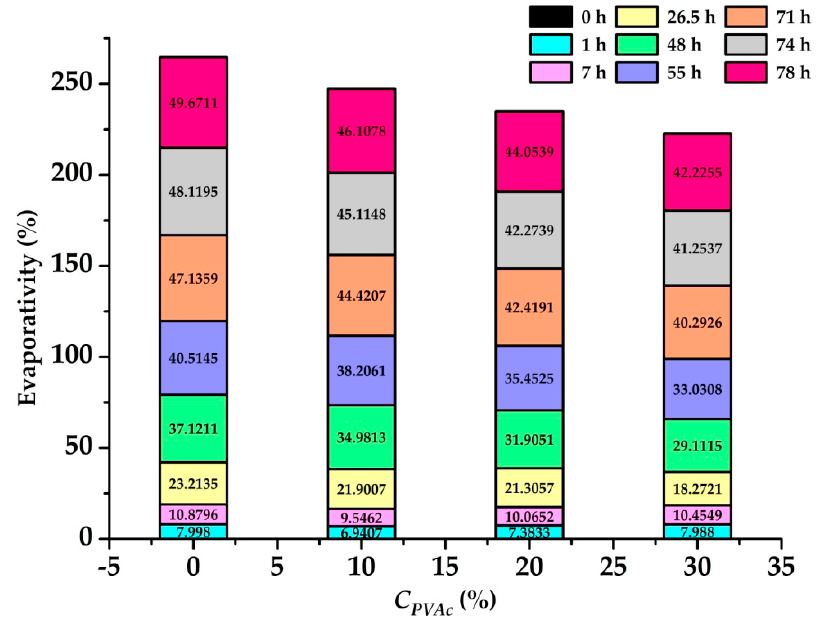
Figure 6. The relationship between C PVAc and evaporativity.